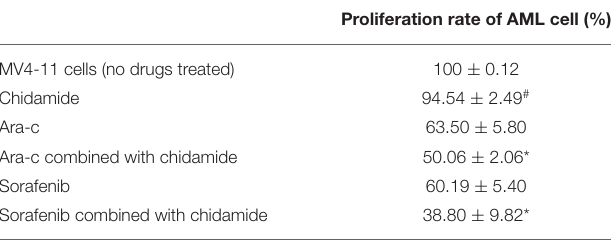
* The proliferation rate of MV4-11 cell lines treated in combined with chidamide for 24h compared with the proliferation rate of MV4-11 cell lines treated by Ara-c or